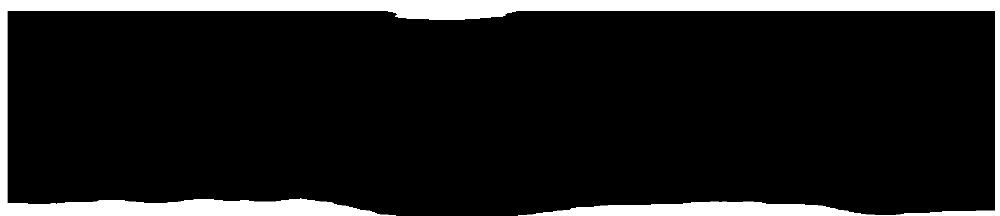
Figure 7. Convolution results of selected regions.